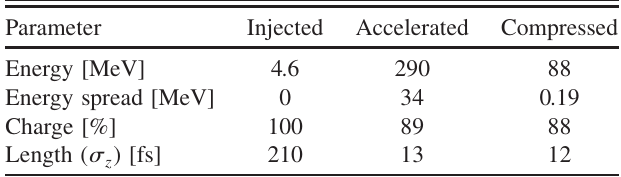
TABLE II. Properties of the electron bunch before injection and when exiting the plasma in the accelerator and compressor schemes.